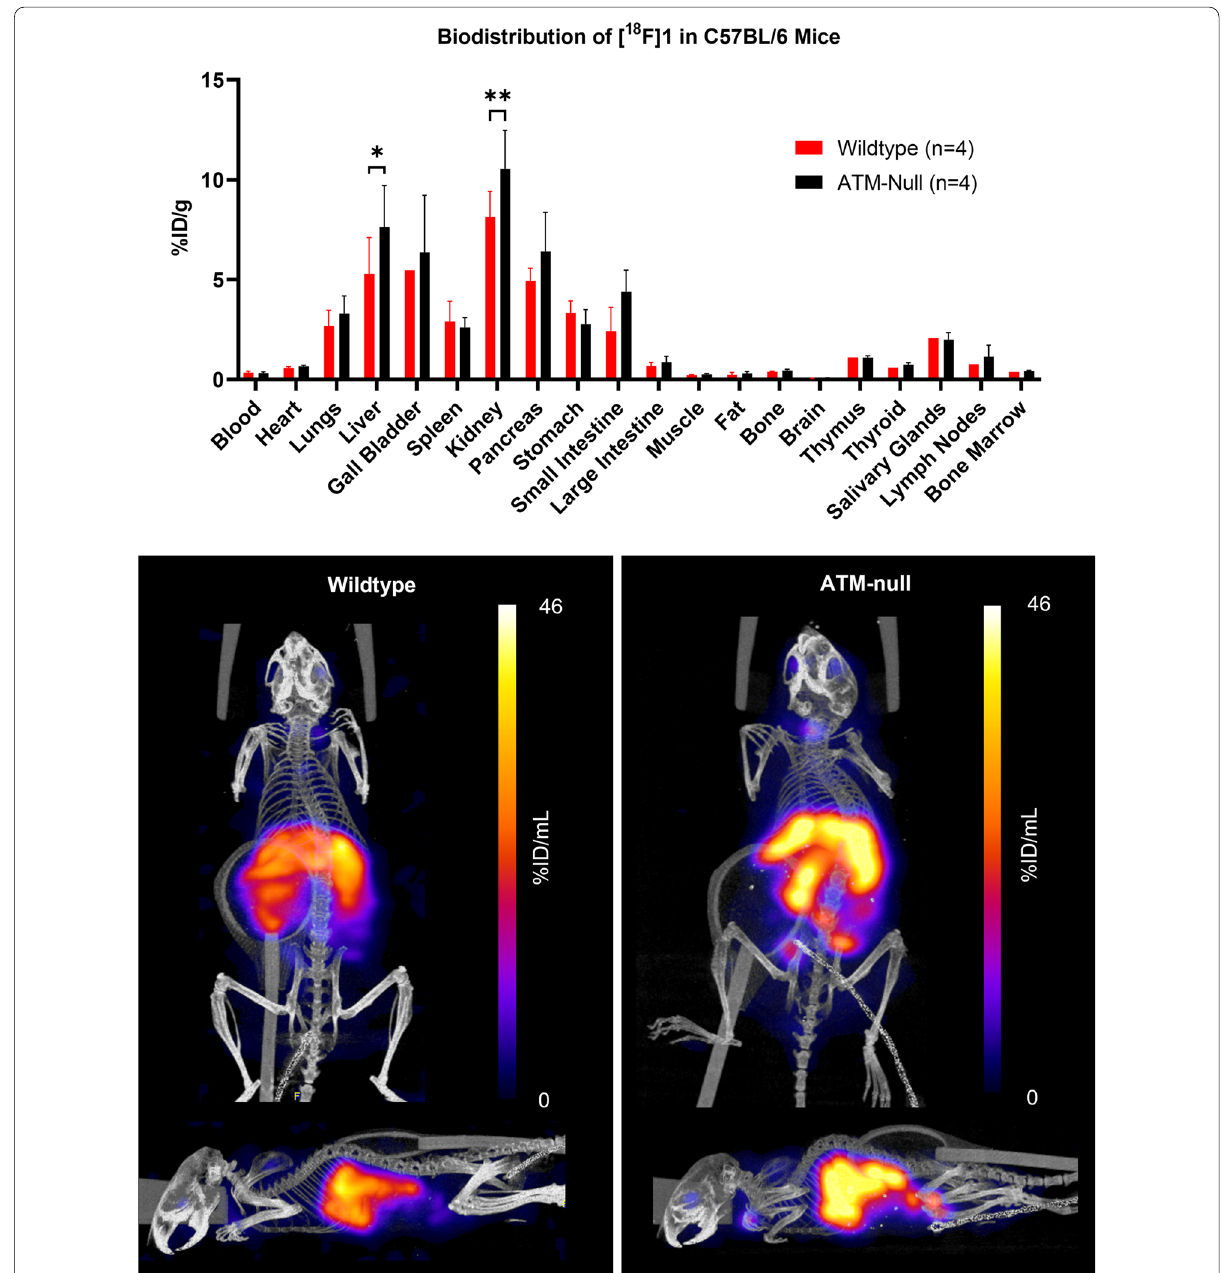
Fig. 5 Biodistribution of [ 18 F] 1 in C57BL/6 ATM wild type and ATM-knockout mice, 1 h after intravenous administration. Below are